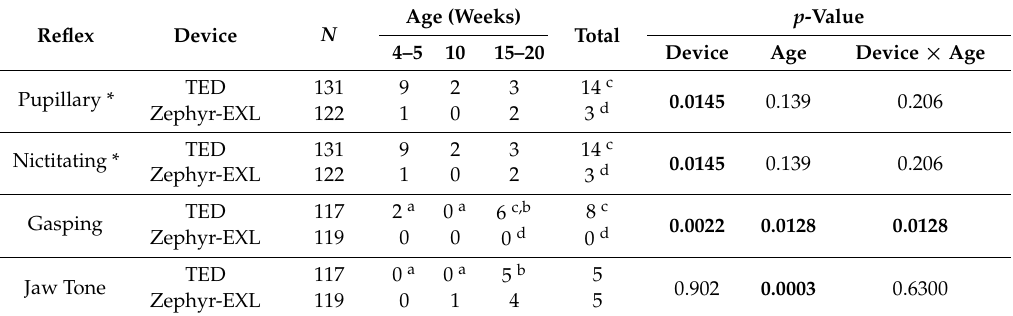
Table 5. Number of birds presenting with reflexes and involuntary behaviours following application of the Turkey Euthanasia Device (TED) and